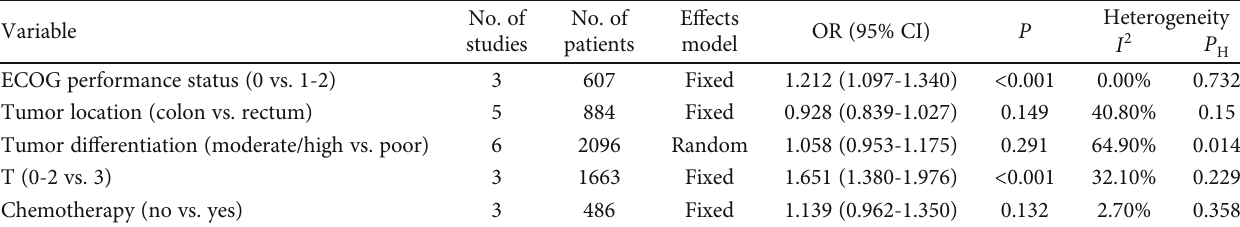
Table 3: Associations between SII and clinicopathological parameters.